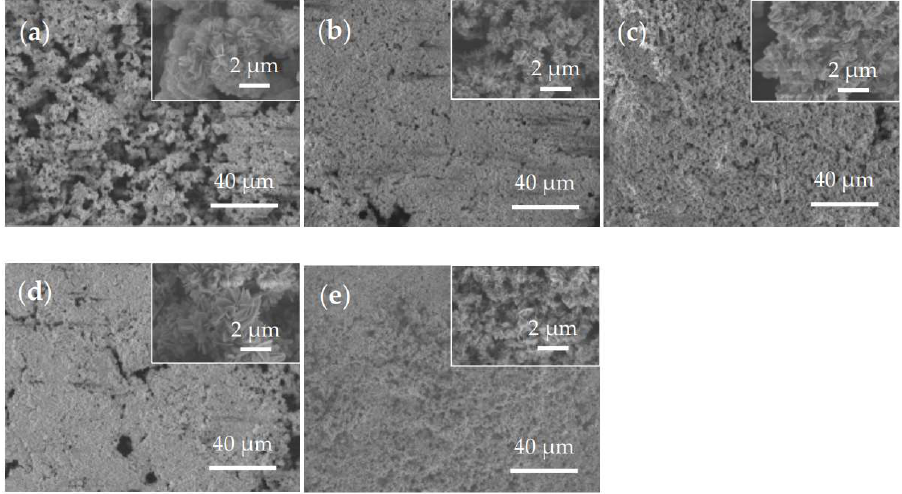
Figure 3. Surface morphology of the rust layer: ( a ) 48 h in 3.5% NaCl; ( b ) 144 h in 3.5% NaCl; ( c ) 288 h in 3.5% NaCl; ( d ) 144 h in 2.0% NaCl; and ( e ) 144 h in 5.0% NaCl.